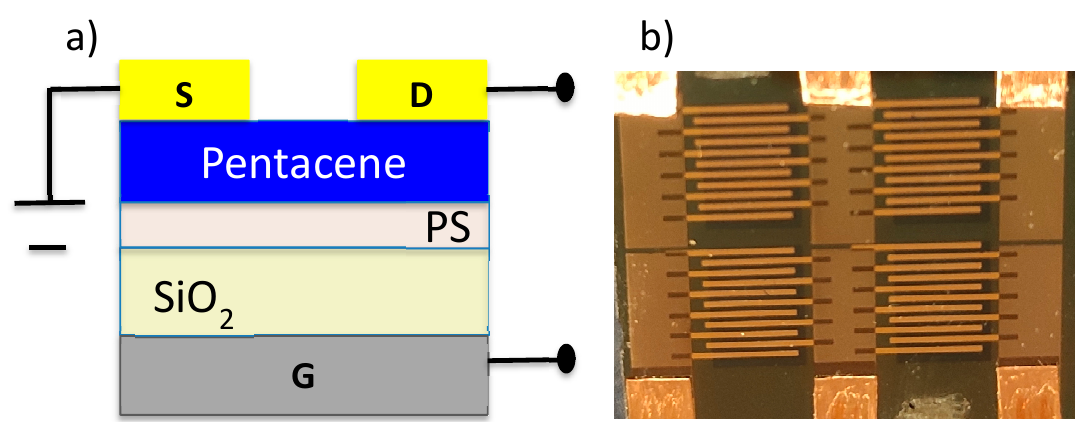
Figure 2. ( a ) Schematic configuration of the pentacene-based OTFT electret detector. ( b ) The top view of four transistors with interdigitated electrodes. Figure 2 (a) Schematic configuration of the pentacene-based OTFT electret detector. (b) The top view of four transistors with interdigitated electrodes.